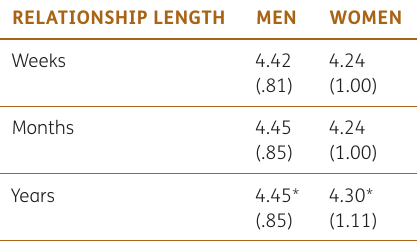
Table 3 Mean (and SD s) Judgments of Perceived